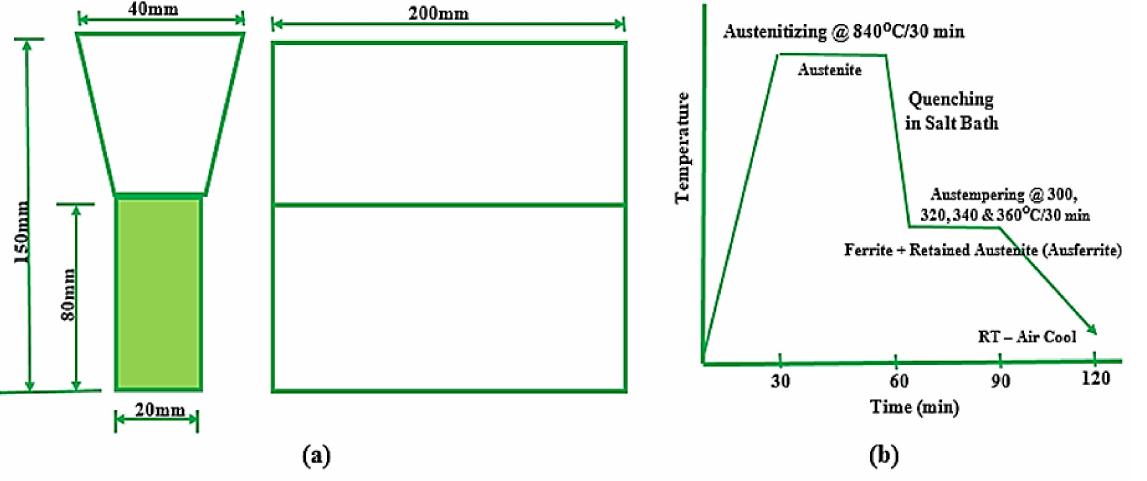
Figure 7. ( a ) Y-block shape and ( b ) stages involved in austempering of ADI